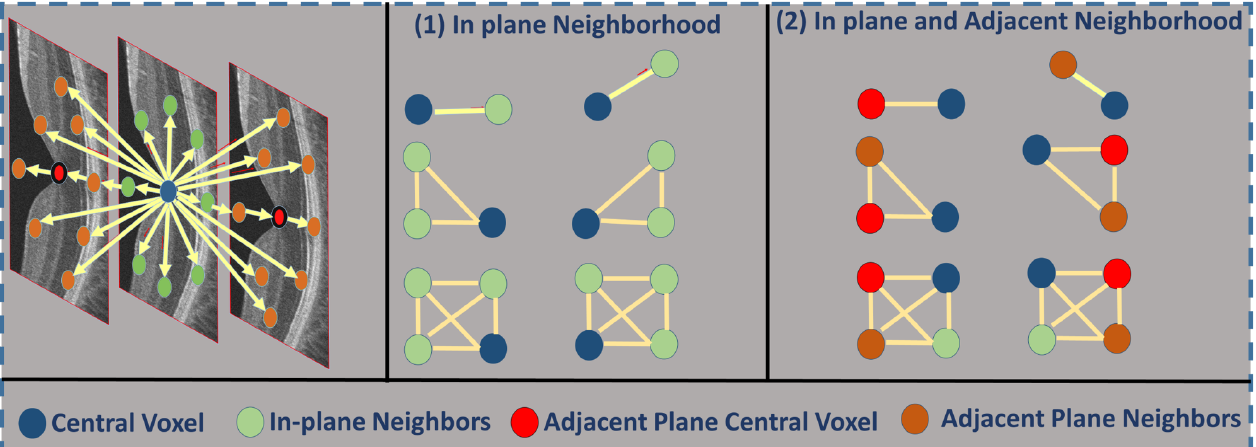
Figure 4. A graphic representation of 26 neighborhood voxels (left panel) for the higher-order 3D- MGRF model; and examples of different order cliques of center voxel (blue) and its neighbors in the same plane (middle panel) and adjacent planes (right